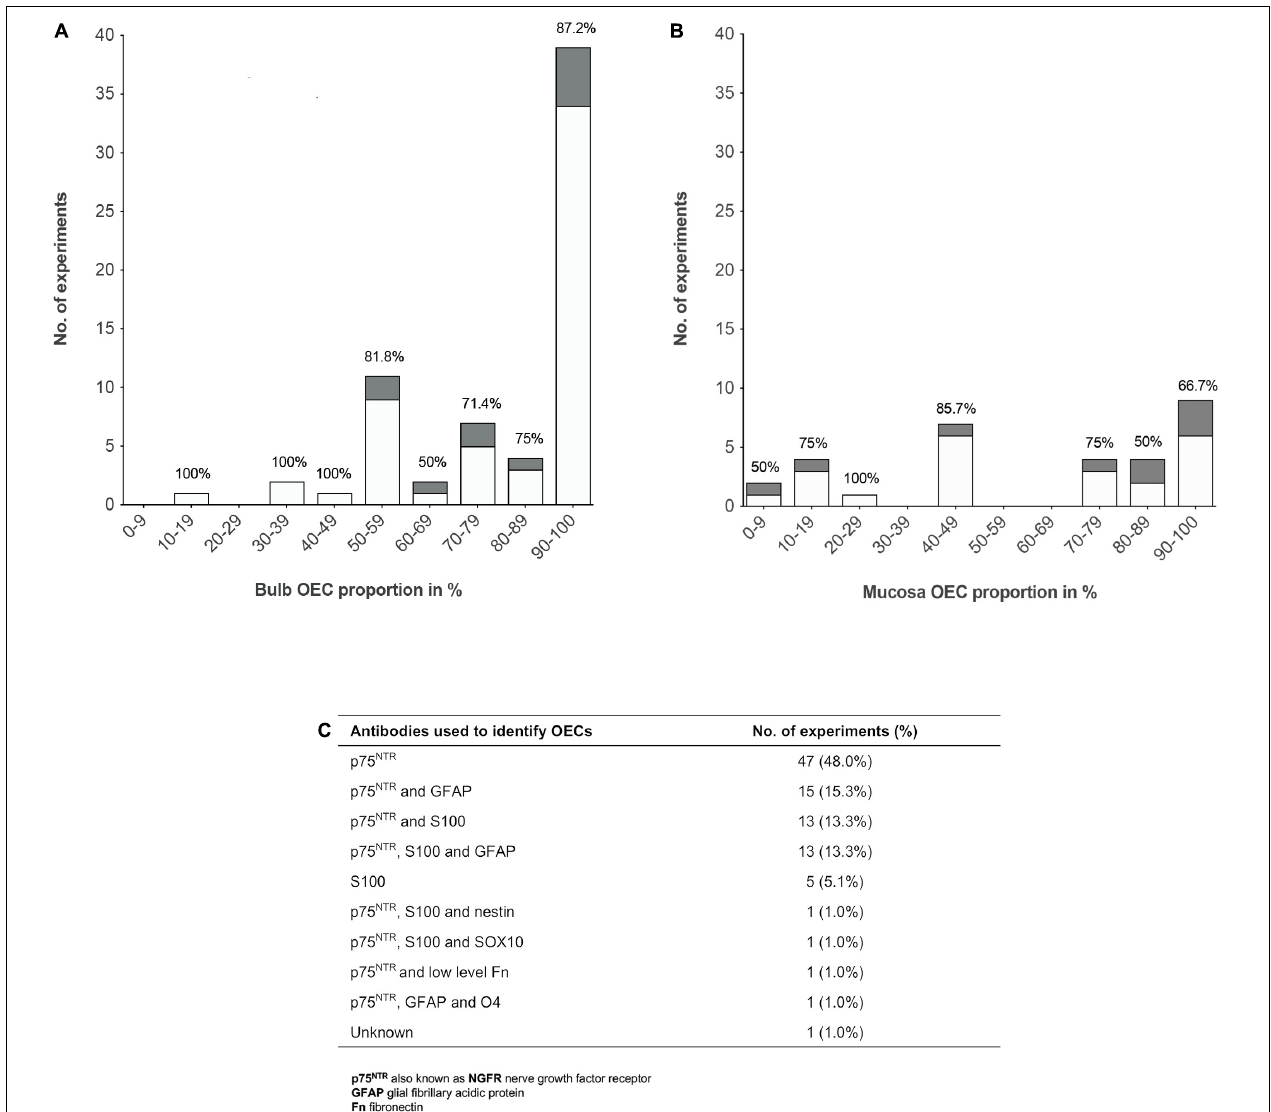
FIGURE 3 | Comparison of the impact of OEC proportions in olfactory cell transplants on therapeutic outcome. (A) Comparing the% proportion of olfactory bulb derived OECs on therapeutic outcome. Each bar is labeled with the% of positive outcome for each condition ( n = 67 experiments). (B) Comparing the% proportion of olfactory mucosa derived OECs on therapeutic outcome. Each bar is labeled with the% of positive outcome for each condition ( n = 31 experiments). (C) Immunocytochemical makers used in the characterization of OECs in the studies included in the review ( n = 98 experiments). The white bars represent the positive outcome experiments and the gray bars represent the negative outcome